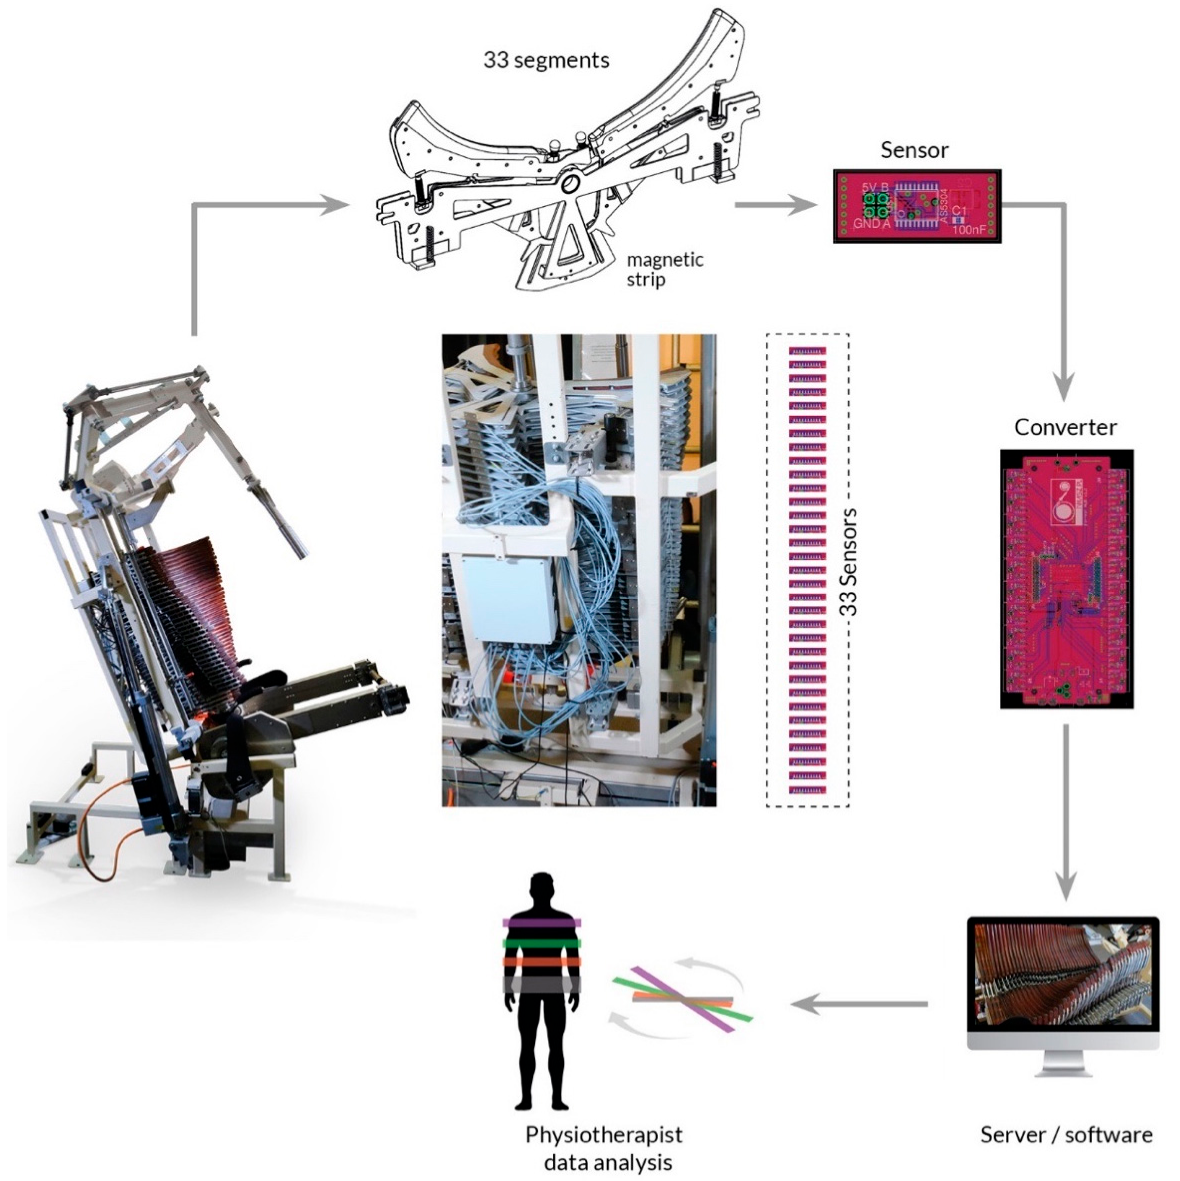
Figure 3. The dynamic spine correction (DSC) device has a “board,” which is a concave surface composed of a series of movable, curved elements (segments) that collectively support the patient’s back. The device includes a base and a mobile frame on which the board is mounted. The in-built measurement system includes a converter (hub), a server, and a monitor. The converter is connected to sensors that record the rotational positions of the individual segments in reference to the corresponding magnetic tape strips. The server provides feedback, which responds to the detected data, on the monitor.